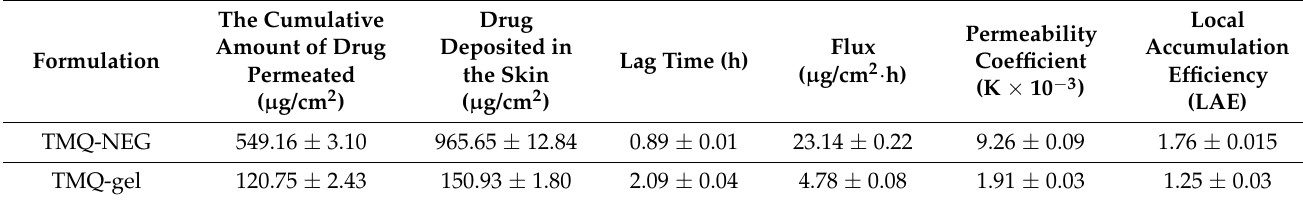
Table 2. Characterization of TMQ-loaded NEG to determine skin penetrability profile compared to TMQ-gel. The Formulation